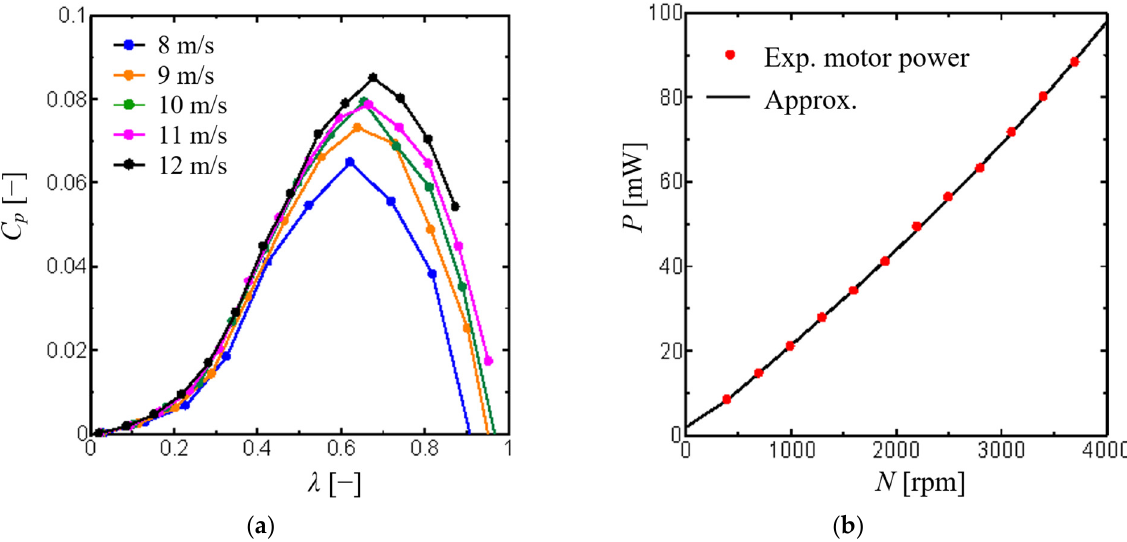
Figure 5. Experimental data of a 3D ‐ printed miniature rotor: ( a ) power coefficient as a function of tip speed ratio; ( b ) power as a function of rotational speed (reproduced with permission from Jodai and Hara [20]).